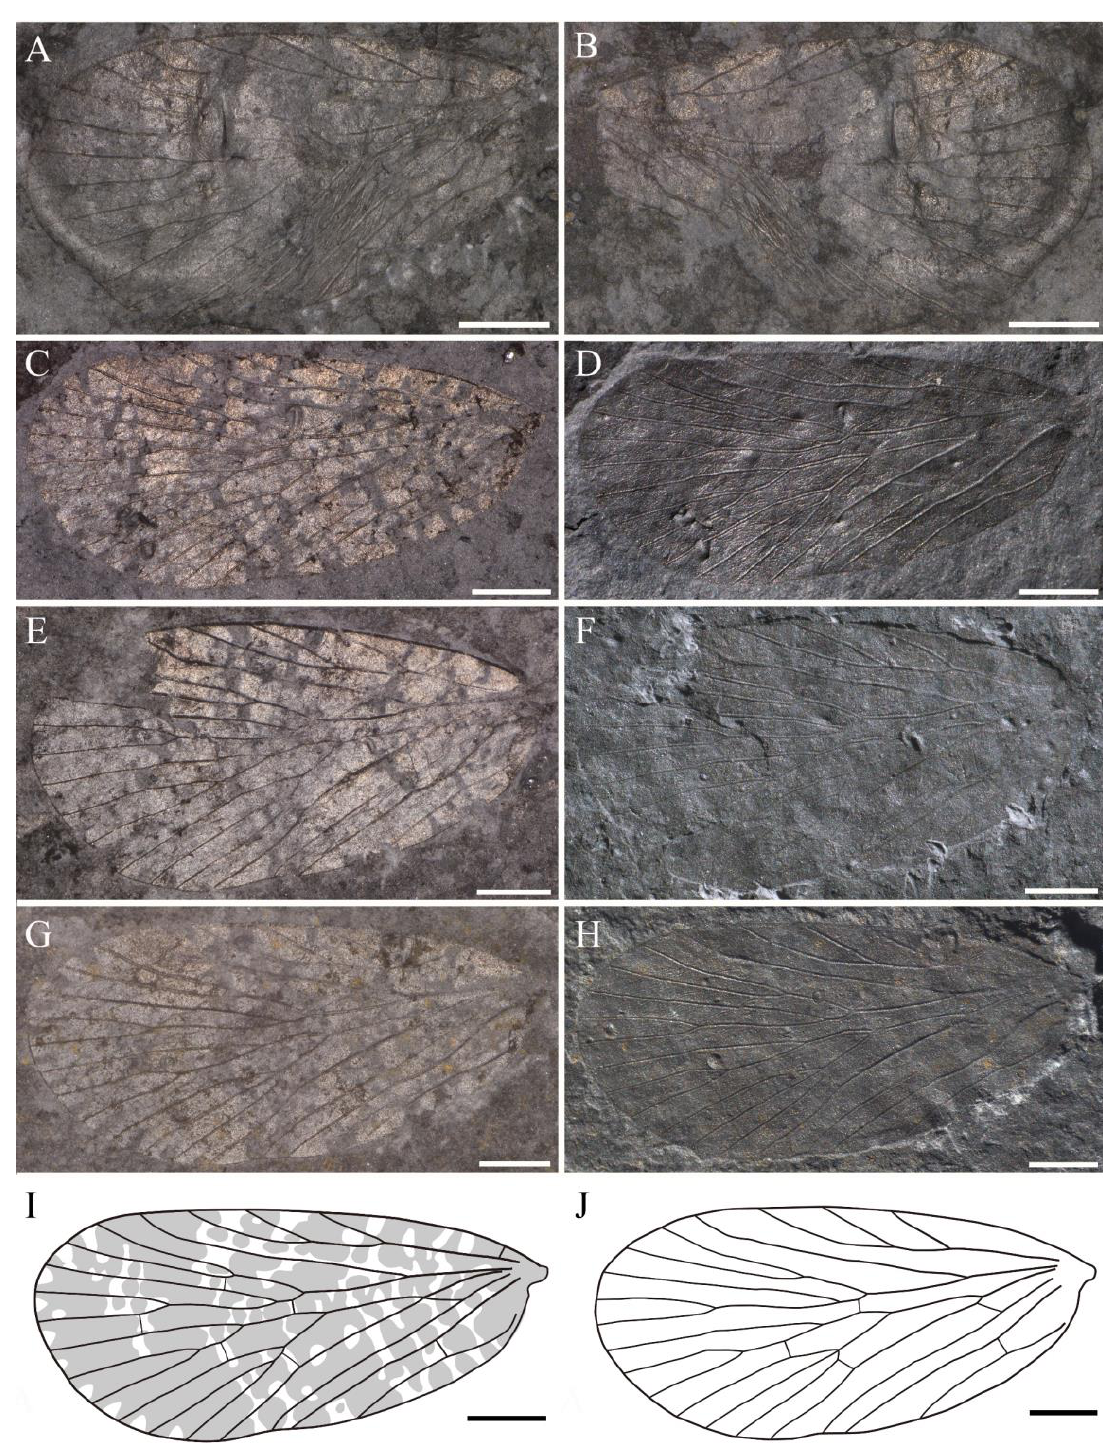
Figure 3. Sinoagetopanorpa permiana Lin, Nel and Huang, 2010. ( A ) Photograph of part of NIGP143428 (holotype); ( B ) Photograph of counterpart of NIGP143428 (holotype); ( C , D ) Photographs of NIGP200888 (paratype); ( E , F ) Photographs of NIGP200889 (paratype) (mirror image); ( G , H ) Photographs of NIGP200890 (paratype); ( I ) Line drawing of NIGP200888; ( J ) Line drawing of NIGP200890, dark color not illustrated. ( A – C , E , G ) were taken when specimens were immersed under 70% alcohol in vertical reflected light; ( D , F , H ) were taken in oblique reflected light. Scale bars represent 1 mm in ( A – J ).